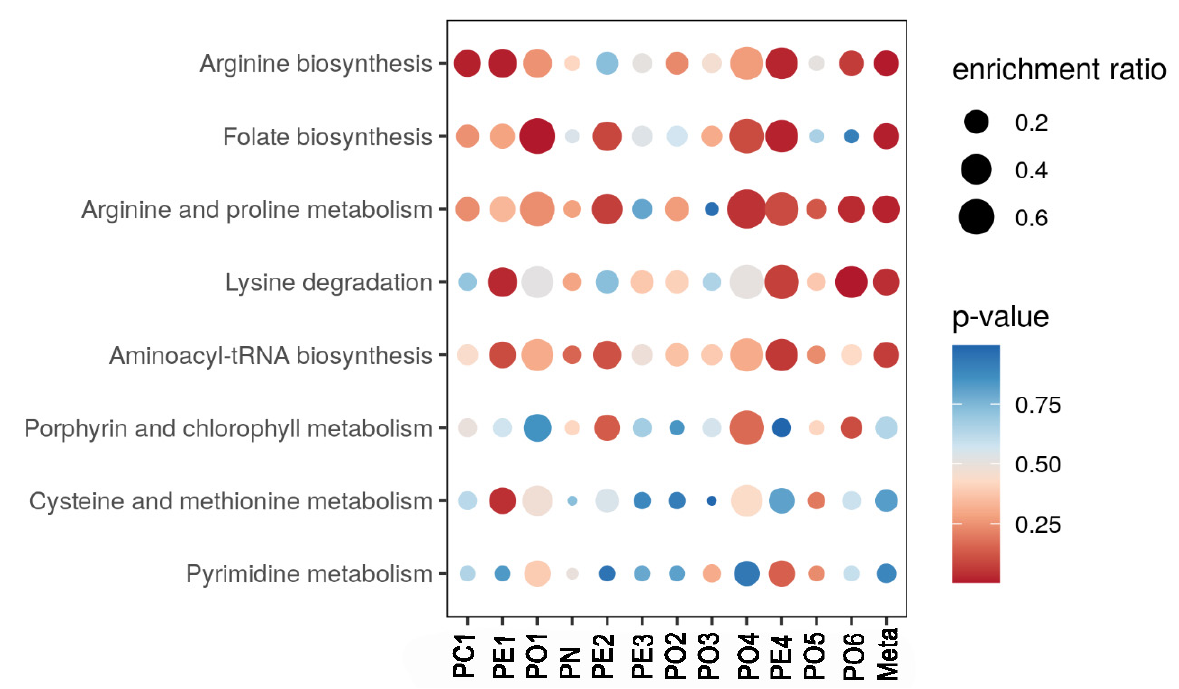
Figure 1. Comparative investigation for exploring the effect of different substrates on the metabolic profile was made between Pleurotus spp. mycelia grown in substrates S2. Substrate S1 was taken as a reference and data were calculated as mean differences compared to S1 (calibrator of the relative quantification). In the figure, red indicates a higher probability of metabolic pathway activation, whereas blue suggests a minor one.